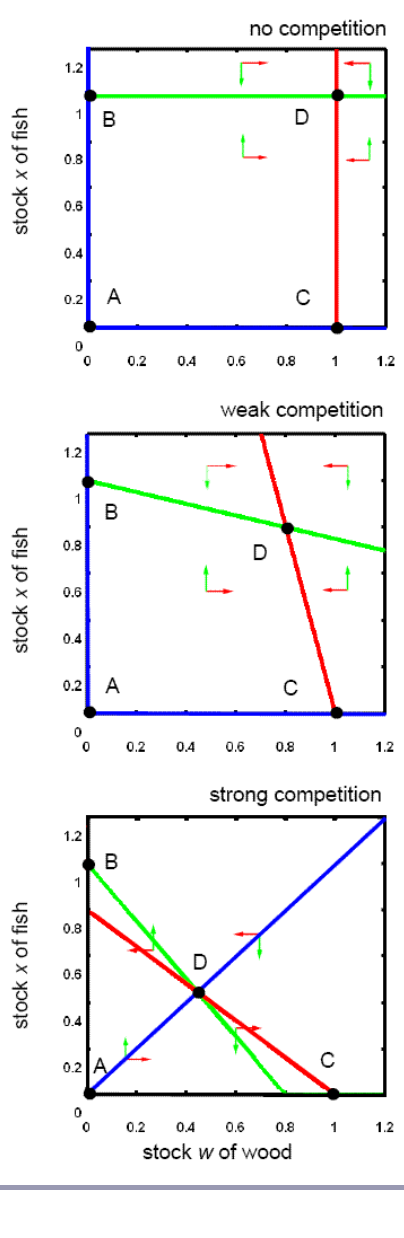
Fig. 1. Phase diagrams in state space for the ecosystem’s natural dynamics without any harvesting (C = H = 0). Dynamics are characterized by dx/dt > 0 (< 0) below (above) the green line, and dw/dt > 0 (< 0) left (right) of the red line. Blue lines indicate saddlepaths. The upper diagram displays the case of independent species ( g x = g w = 0). In the middle diagram interspecies competition is weaker than intra-species competition ( g x = g w = 0.25), and in the lower diagram, interspecies competition is stronger than intra- species competition ( g x = g w = 1.25). Parameter values for all diagrams: r x = r w = 0.5, k x = k w =